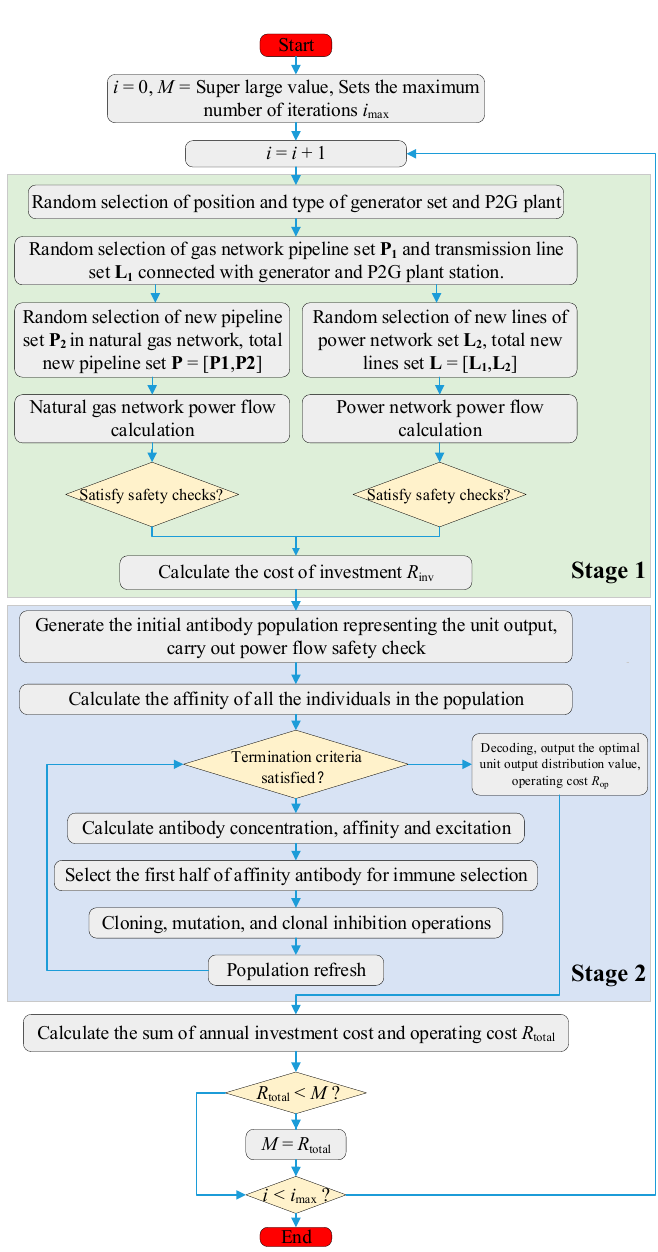
Figure 1. The flow chart of the algorithm.